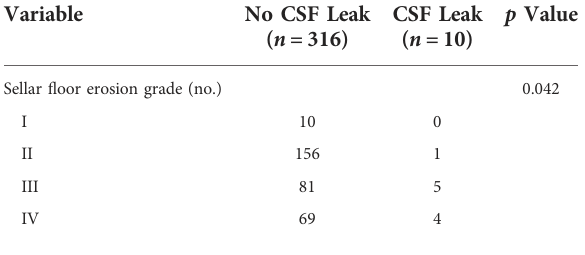
TABLE 2 Sellar fl oor erosion grades of patients.